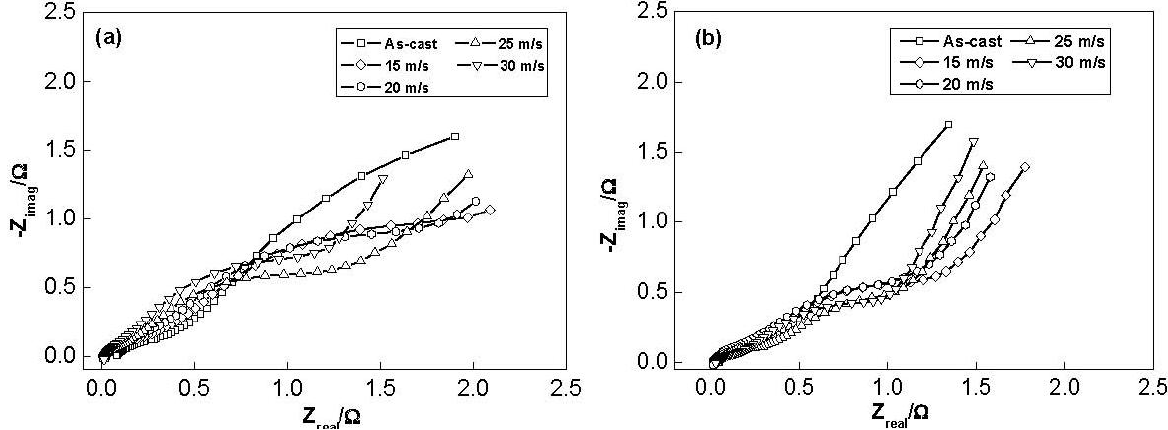
alloy; ( b ) Co 0.1 0.4